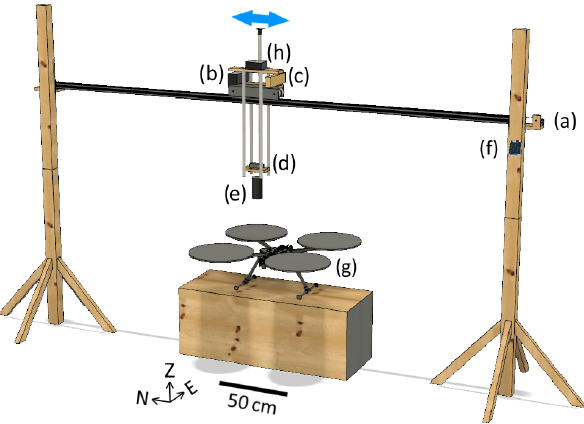
Figure 2. Magnetic scanner composed of (a) two stepper motors, (b) a magnetometer battery, (c) a magnetometer data acquisition system (DAS), (d) a triaxial fluxgate magnetometer, (e) a total field magnetometer, (f) a stepper motor control board, (g) a UAS, and (h) a fluxgate DAS. Cables are removed for simplicity.